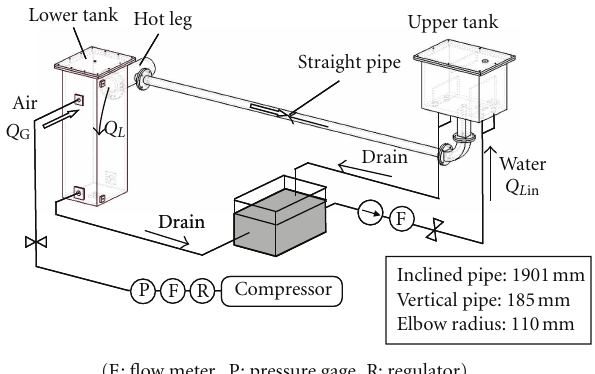
Figure 3: Experimental apparatus with straight pipe.